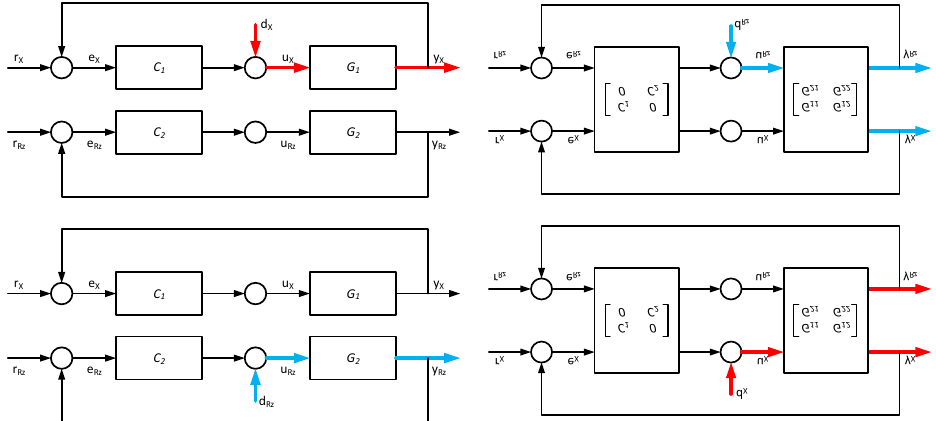
Figure 10. Pilot 1 GSC system identification: Left—traditional way (before the project); Right—BB8 MIMO identification (at the end of the project).